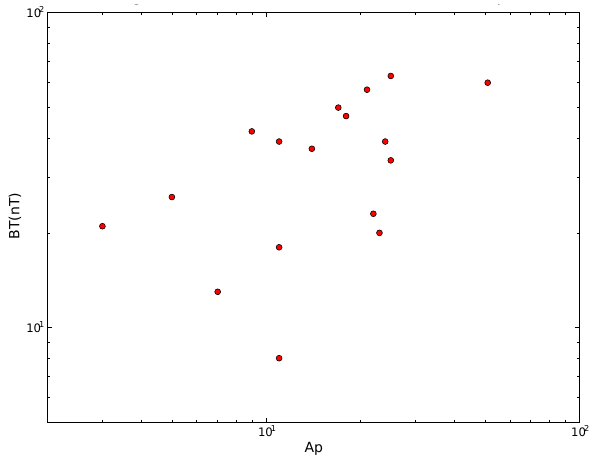
Figure 9: Observed relation between Bn and Ap